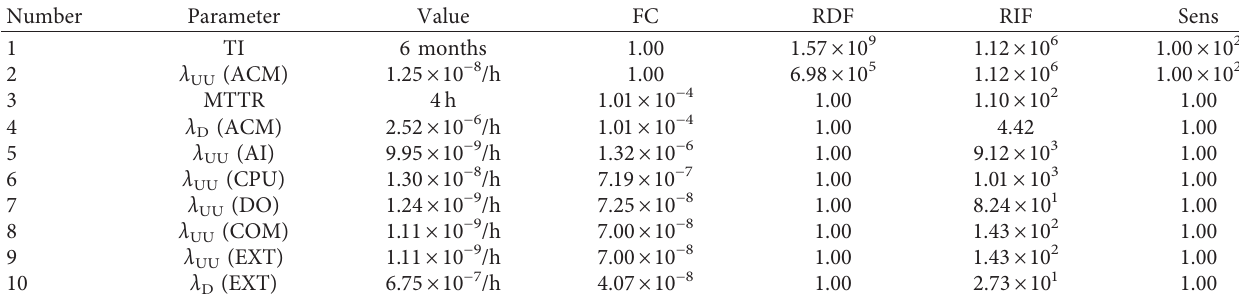
Table 6: Importance and sensitivity of the selected parameters on system risk.